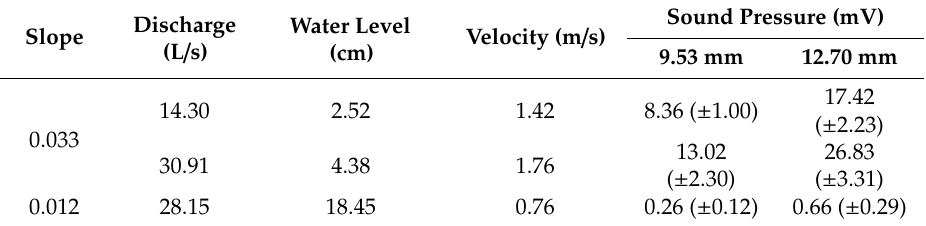
Table 6. Changes of sound pressure by particle size according to hydraulic